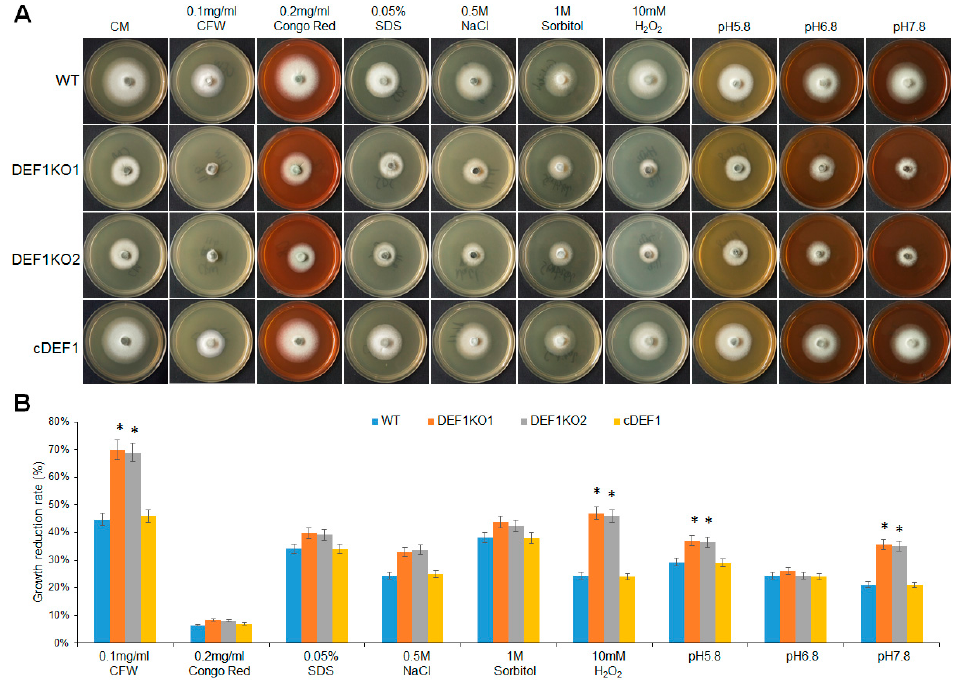
Figure 7. Def1 is involved in various stresses responses. ( A ) The colony morphology of different strains grown on CM plates containing different stress agents at 28 ◦ C for 5 days. ( B ) Growth reduction rates calculated by colony diameter of different strains growing under different stress for 5 days. Significant differences are labelled with asterisks (*, p < 0.05). WT, wild type; DEF1KO1 and DEF1KO2, two independent def1 knock out mutants; cDEF1, complementary strains.